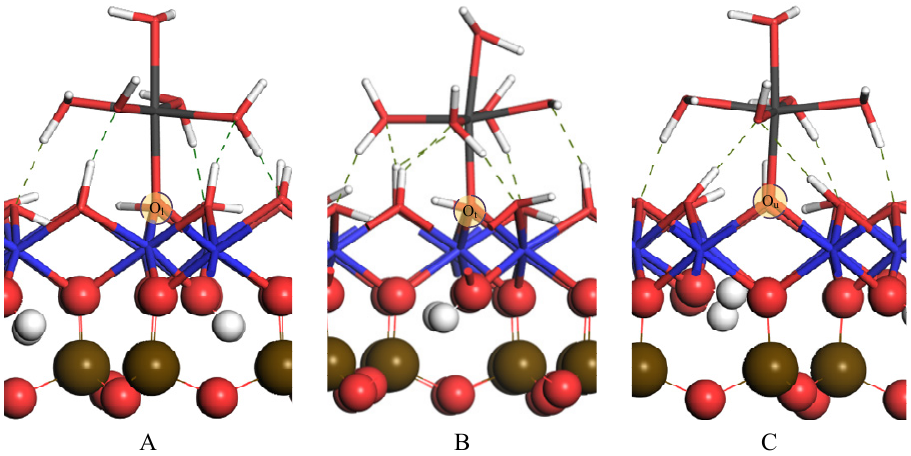
Figure 7. Picture of monodentate adsorption structures of Fe at “O l ” ( A ), “O t ” ( B ), and “O u ” ( C ) the positions on Al-OH surface.